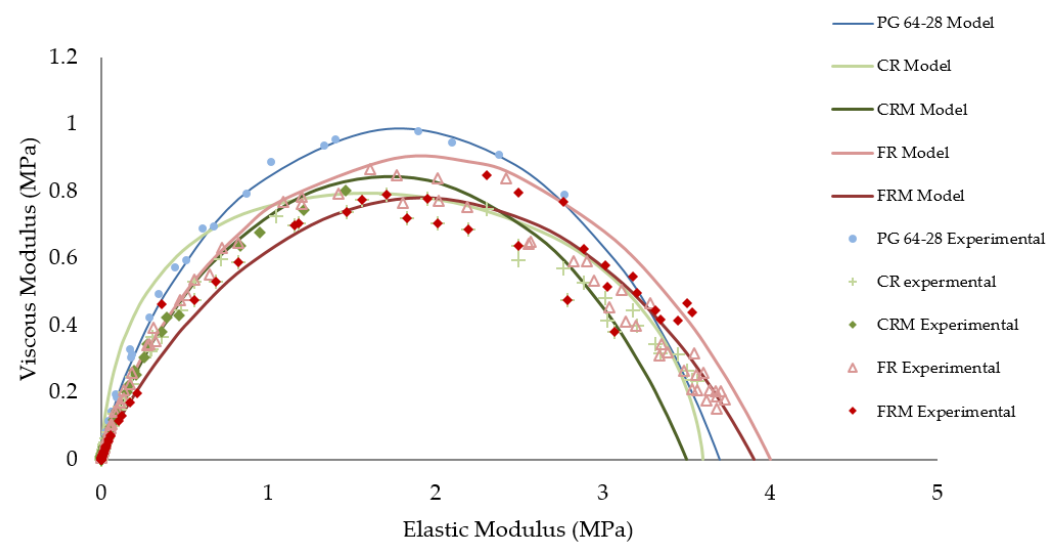
Figure 5. Cole–Cole shear modulus of recovered bitumen (2S2P1D model).